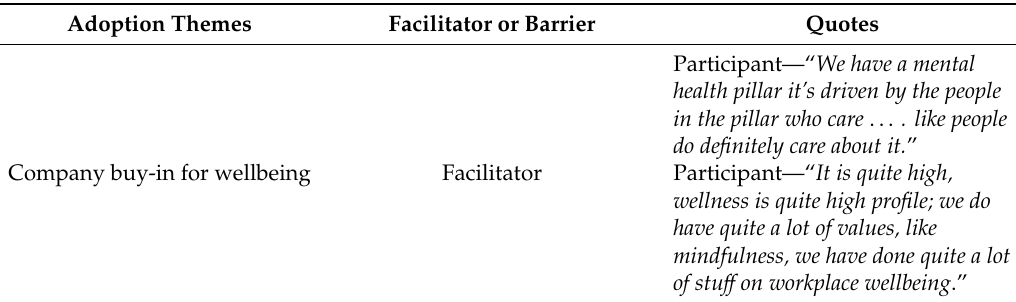
Table 3. Qualitative themes relating to indicators of